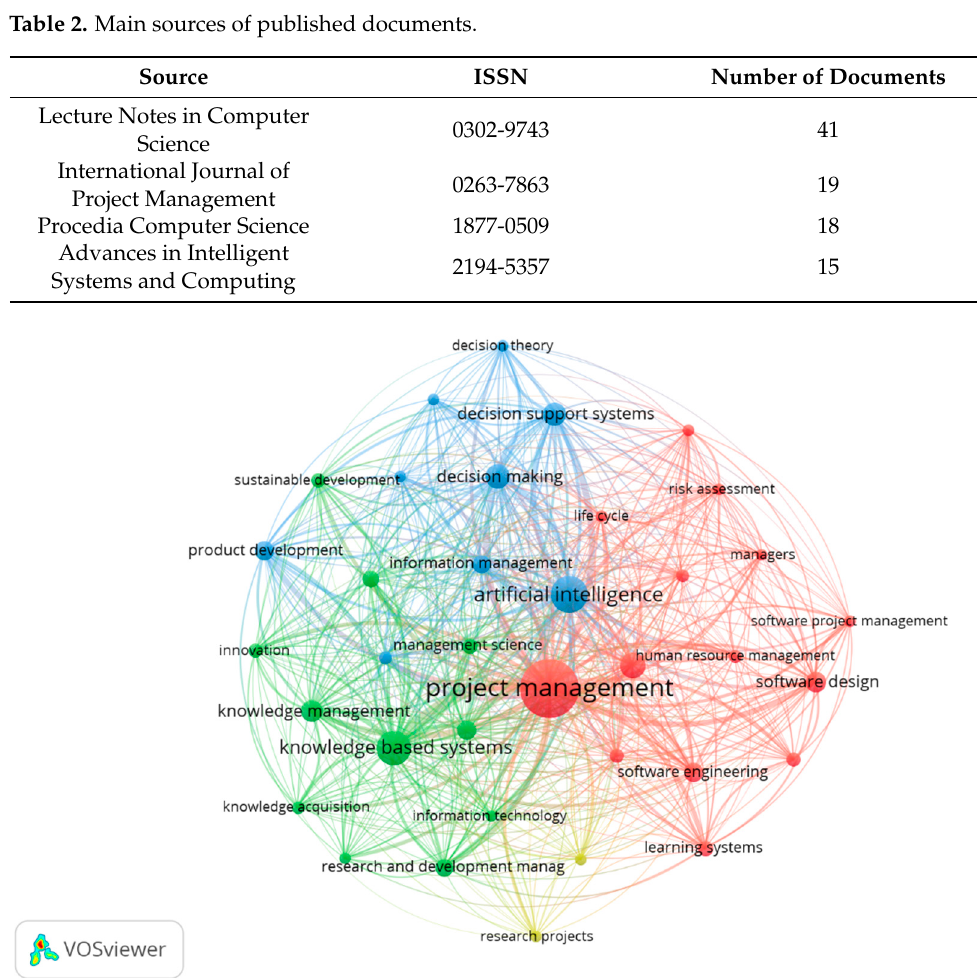
Figure 2. Clusters identified by VOSviewer.